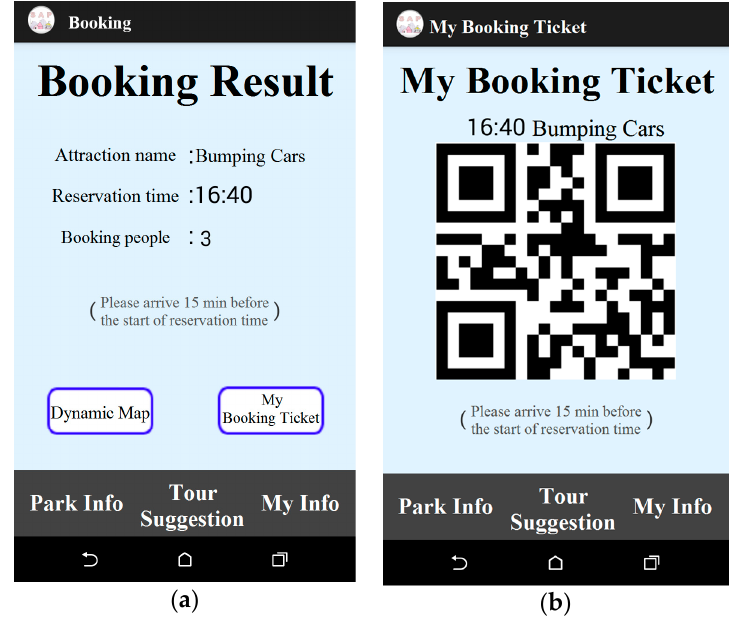
Figure 12. Testing result of the attraction reservation function: ( a ) result of the successful reservation of attraction; and ( b ) the booking ticket of the visitor.